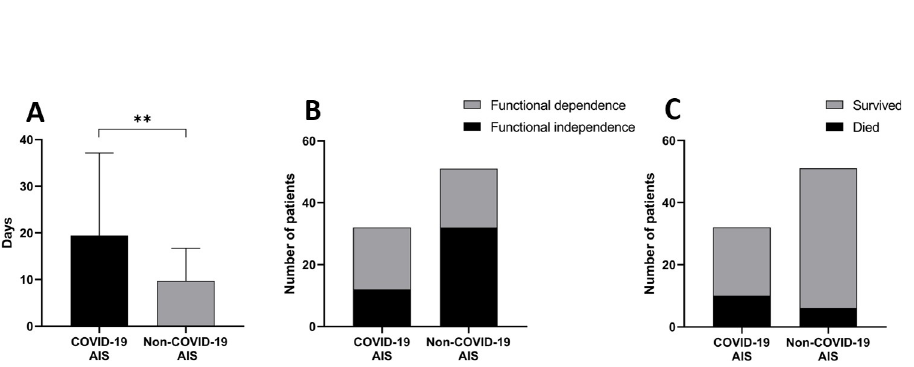
Fig 3. Summarizes the length of hospitalization and outcome result in COVID-19 AIS and non-COVID-19 AIS patients. (A). The average length of hospitalization. A significant difference between treatment duration can be observed. Data are presented as mean ± SD. �� p < 0.01. (B). Functional state at discharge. Non-COVID-19 AIS patients showed significantly more favorable functional outcomes (mRS � 2) than COVID-19 patients; p = 0.02 (C). In-hospital mortality rates. There is significantly higher mortality in COVID-19 AIS patients; p = 0.02.